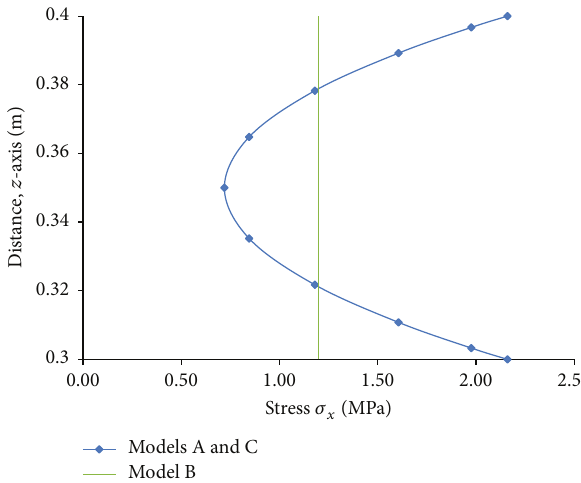
Figure 8: Variation of normal stress, 𝜎 𝑥 , in thinner plate at step.